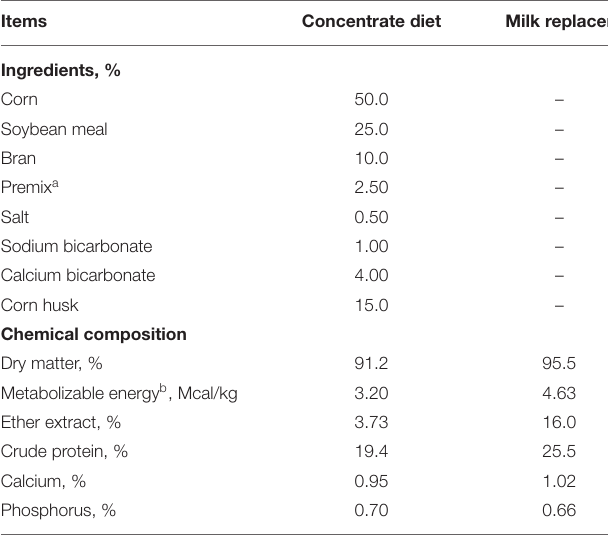
TABLE 1 | Ingredients and chemical composition (dry matter basis) of the concentrate diet and milk replacer.